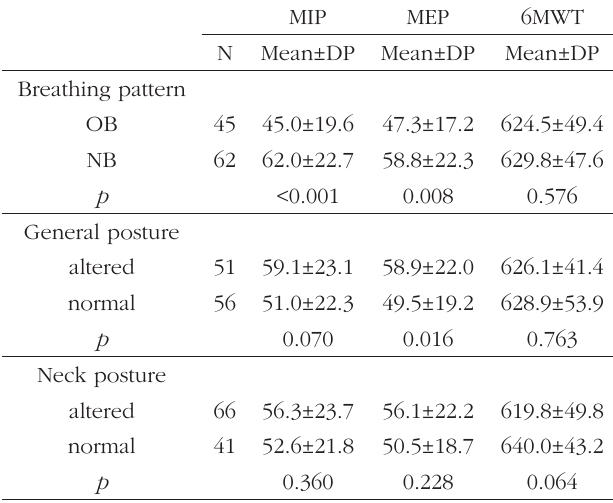
Table 3. Distribution of mean MIP, MEP, and 6MWT results in relation to the breathing pattern, and general and neck